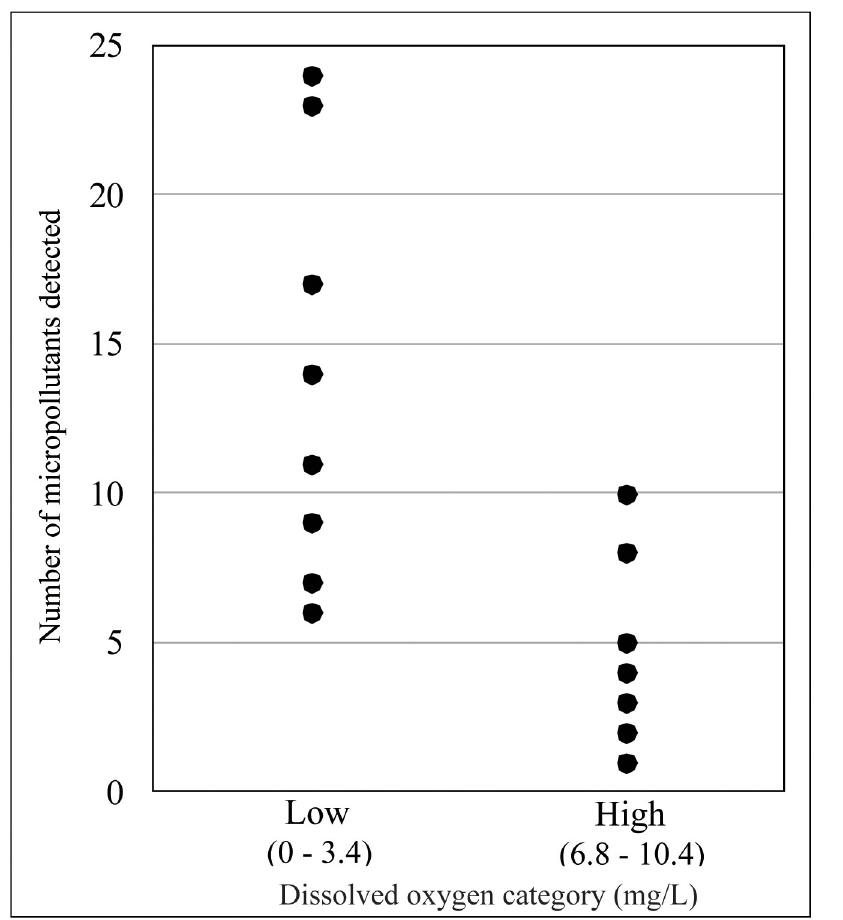
Fig 4. Number of micropollutants detected by dissolved oxygen